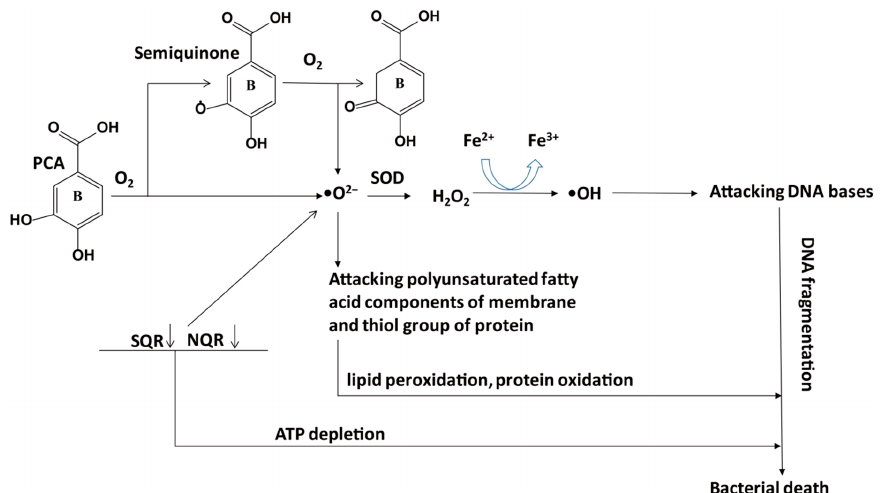
Figure 2. Potential mechanisms underlying the lethal effect of PCA on gram-negative bacteria. Autoxidation of PCA and semiquinone oxidation through the inhibition of